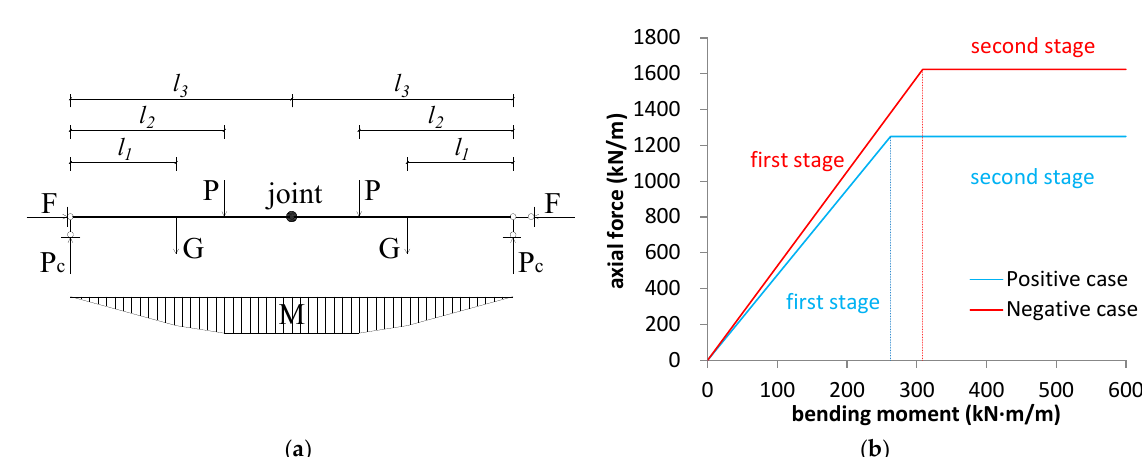
Figure 8. Test loads: ( a ) bending moment diagram; ( b ) exerted axial forces and bending moments at the joint section. Figure 7. Exerted loads: ( a ) positive case; ( b ) negative case.